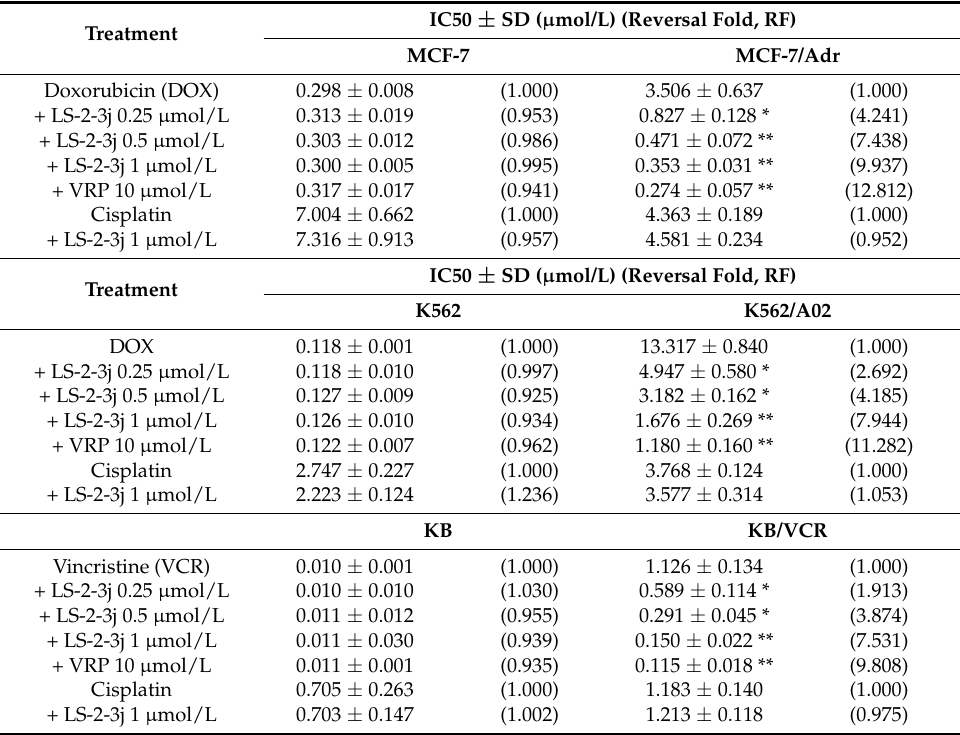
Table 1. LS-2-3j reverses ABCB1-mediated drug resistance in ABCB1-overexpressing cell